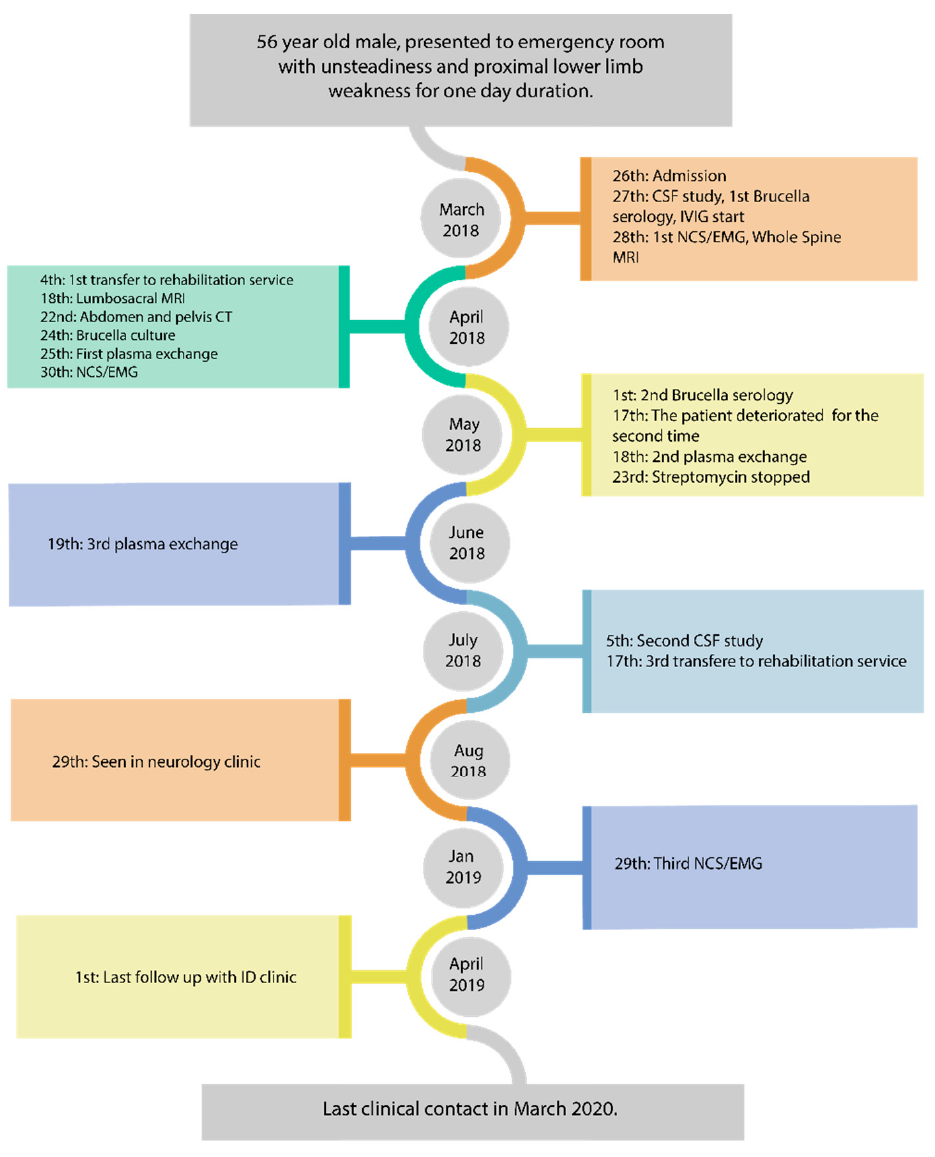
Figure 1. Events sequence for our patient.